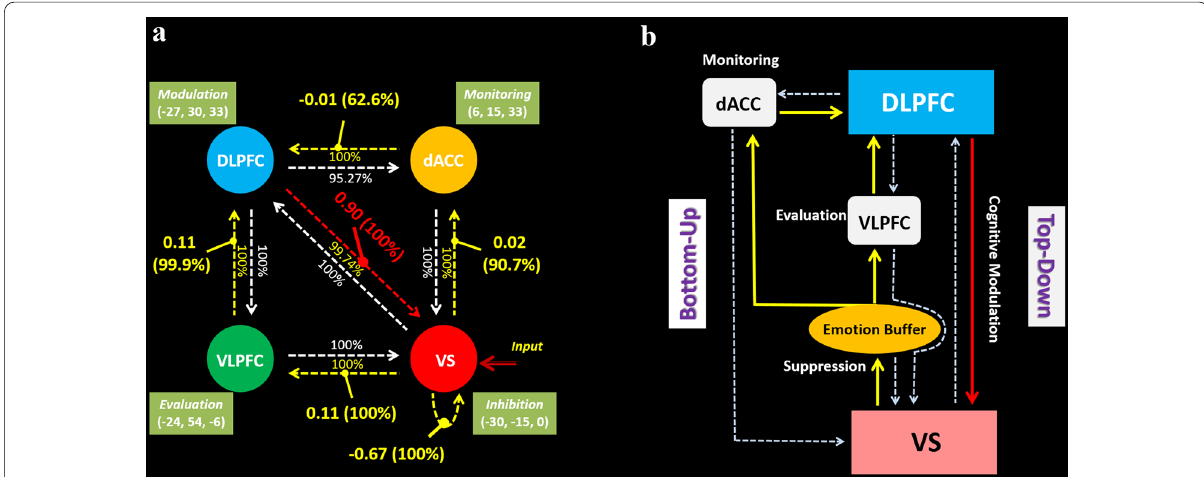
Fig. 3 Dynamic models of implicit self-regulation on aversive emotions. a The No. 33 model was identified as the optimal dynamic causal model among 50 hypothesized models. The dotted lines between any pair of nodes denote the endogenous connections. The dotted lines in yellow or red mean that the corresponding endogenous connections receive modulatory effects during specific task conditions; the dotted lines in white stands for endogenous connections without being modulated; the solid but short lines denote the modulations imposed on endogenous connections by task conditions; the red arrow means the driver input. Bidirectional endogenous connections were identified between each pair of nodes, except the one between dACC and VLPFC. Connection strength and posterior probability are reported for each modulatory effect. b The optimal model is abstracted as a dual regulatory model that is proposed for the implicit self-regulation of aversive emotions. The bottom-up regulation involves an indirect pathway initiated from the VS to the DLPFC via the VLPFC and dACC, respectively, while the top-down regulation involves a modulation imposed by the DLPFC on the VS directly. dACC dorsal portion of anterior cingulate cortex, DLPFC dorsolateral prefrontal cortex, VLPFC ventrolateral prefrontal cortex, VS ventral striatum